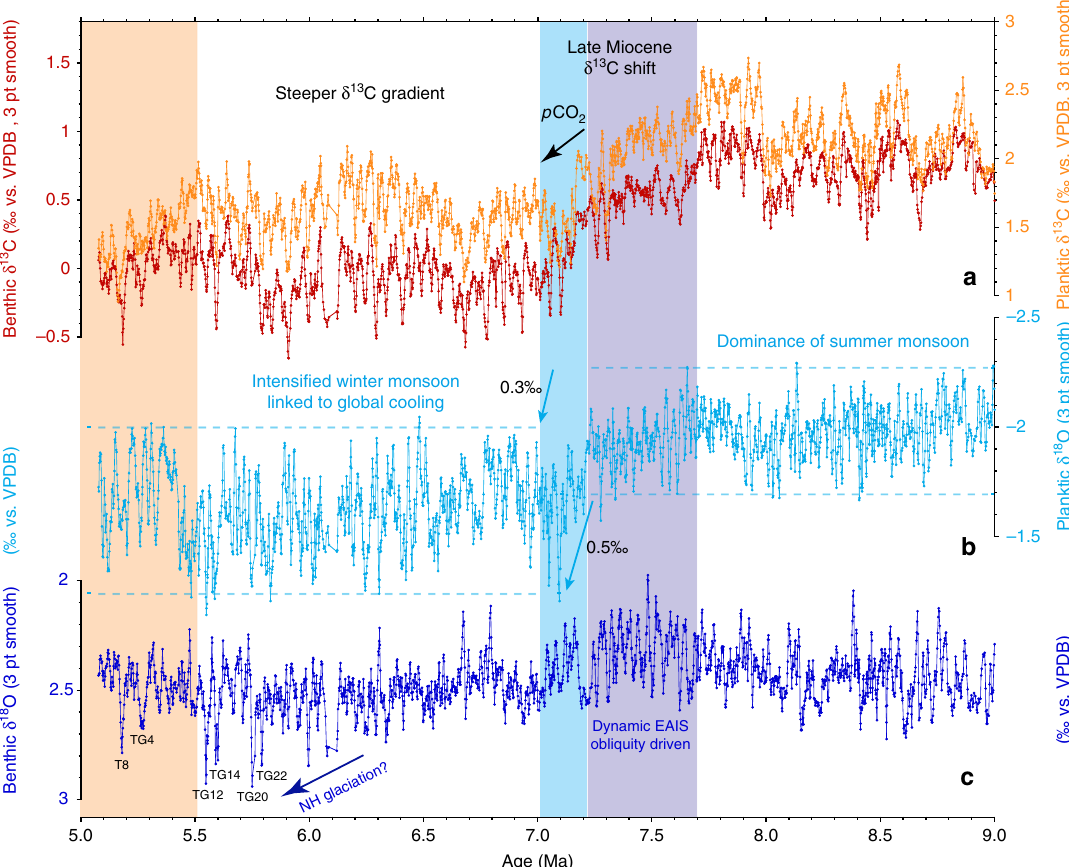
Fig. 2 Late Miocene paleoceanographic records from ODP Site 1146. a Planktic ( G. sacculifer ) and benthic ( C. wuellerstor fi and/or C. mundulus ) δ 13 C. b Planktic ( G. sacculifer ) δ 18 O; dashed lines indicate amplitude variability over intervals 9 – 7.23 Ma and 7.03 – 5.07 Ma. c Benthic ( C. wuellerstor fi and/or C. mundulus ) δ 18 O. Lilac shading marks global δ 13 C decline coincident with planktic δ 18 O increase and high-amplitude obliquity modulation of benthic δ 18 O. Blue shading marks fi nal stage of global δ 13 C decline. Light orange shading marks climate warming after 5.5 Ma. EAIS: East Antarctic ice sheet; 3 pt